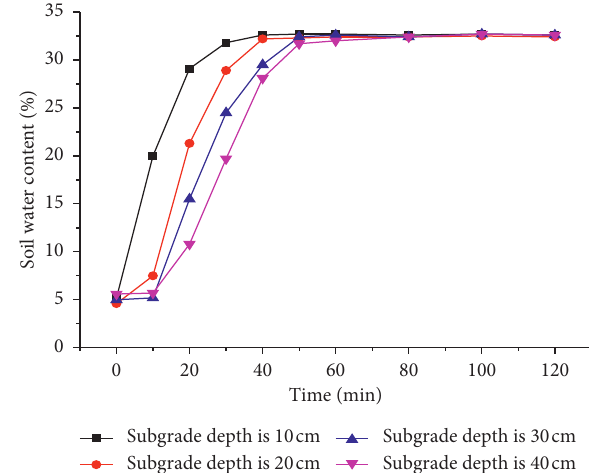
Figure 14: Relationship between soil water content and time.